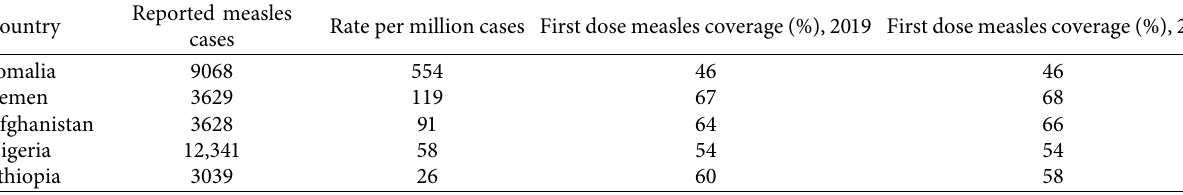
Table 1: Top 5 countries with reported measles cases in the last 12 months, until April 2022. Reported Country